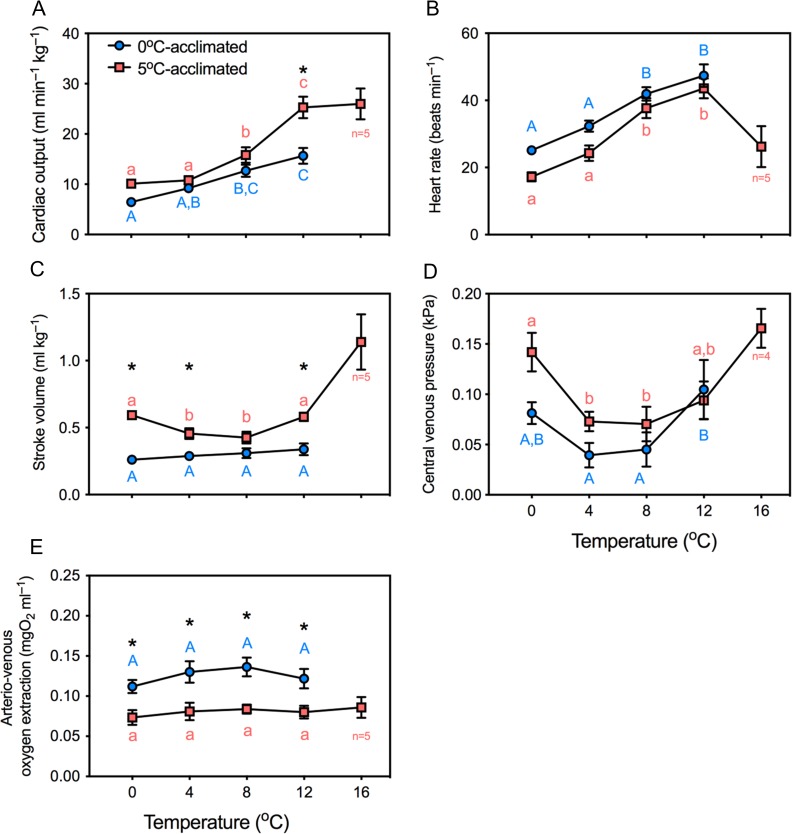
The effects of 0 and 5°C acclimation (6–9.5 weeks) on cardiac output (A), heart rate (B), stroke volume (C), central venous pressure (D) and arterio-venous oxygen extraction (E), during an acute thermal challenge. Significant differences were evaluated with two-way ANOVA. Dissimilar letters indicate significant differences within an acclimation group. Asterisks indicate significant differences between acclimation groups at a given temperature. N values same as for Fig. 3 except central venous pressure where N = 5 for 5°C-acclimated fish (N = 4 at 16°C). Data are mean ± SEM